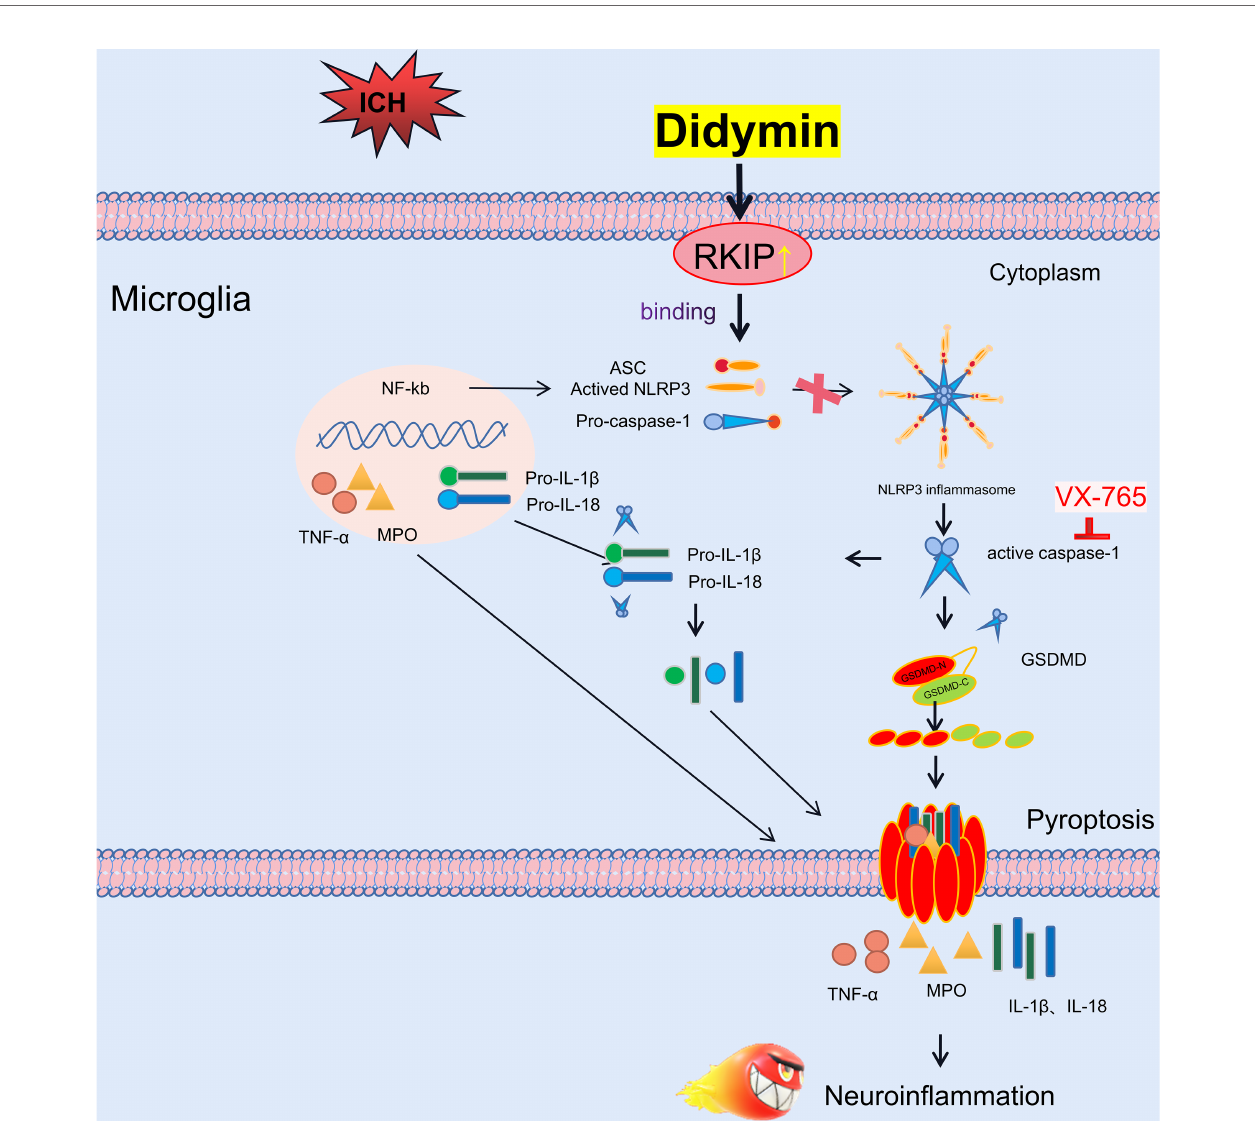
FIGURE 9 | Schematic diagram of potential molecular mechanisms of the anti-neuroin fl ammatory effect of Didymin through the Asc/Caspase-1/GSDMD pathway following